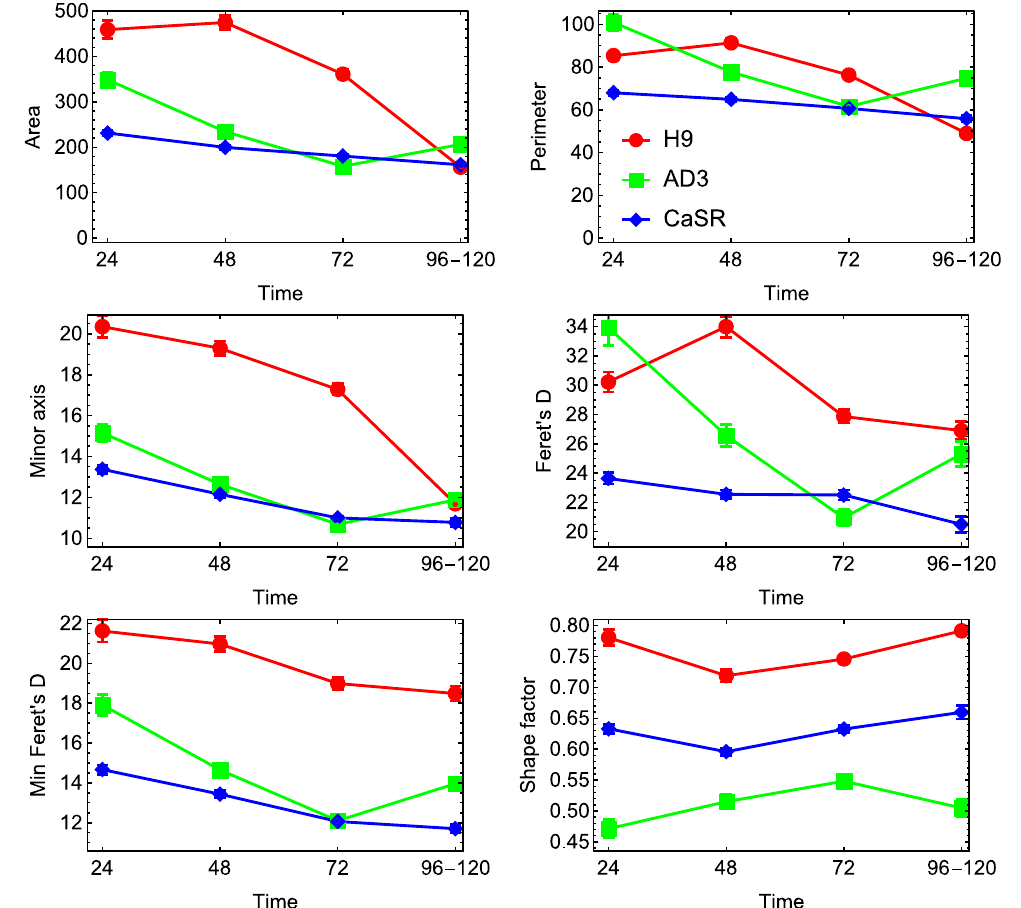
Figure 4. Dynamics of morphological parameters for cells from three cell lines. All designations are as in Figure 3.